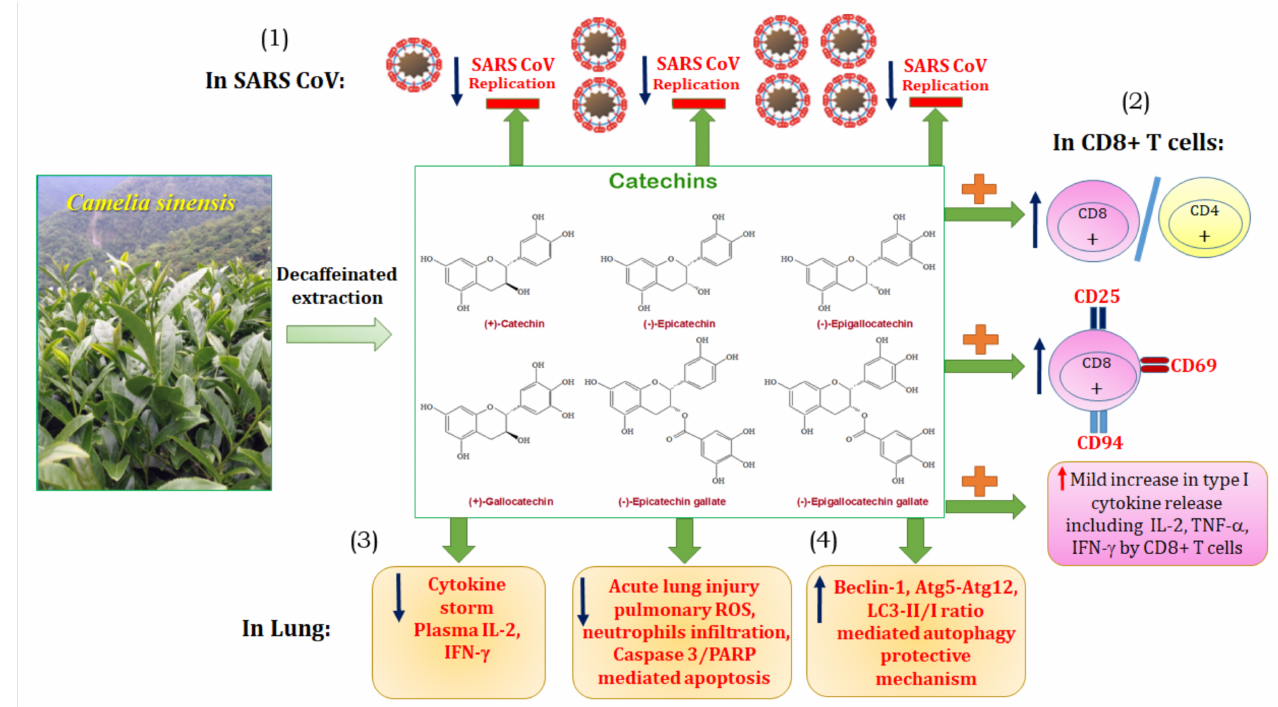
Figure 10. The summary diagram is demonstrated. It is suggested that catechins could be an available candidate drug to meet the requirements, including ( 1 ) the direct inhibiting SARS-CoV replication, ( 2 ) the mild enhancement of CD8 + mediated adaptive immunity, ( 3 ) the decrease of cytokine storm, and ( 4 ) the promoting autophagy-dependent protective mechanism to ameliorate acute lung